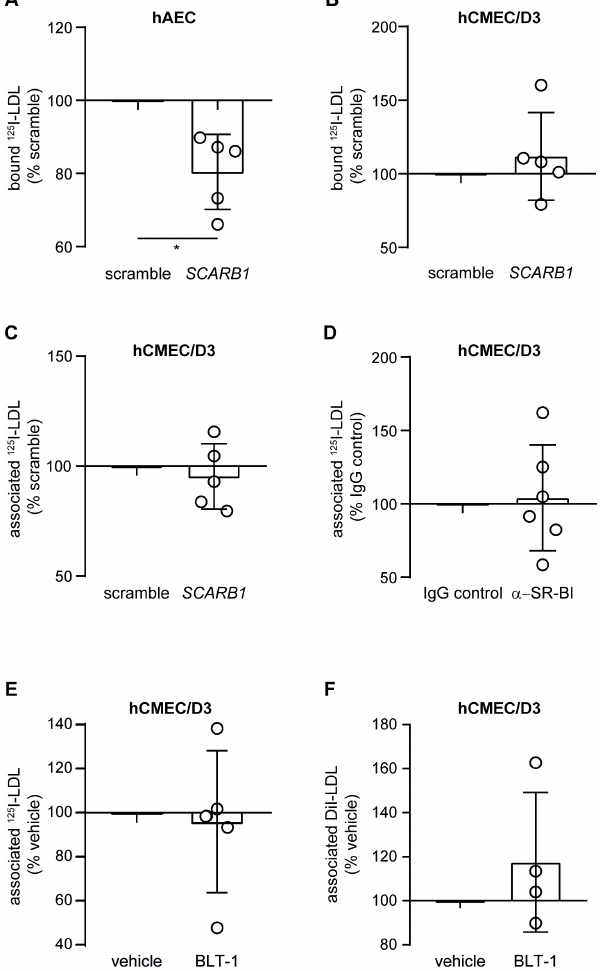
Figure 4. Inhibition of SR-BI reduces LDL binding to hAEC but not to hCMEC/D3. Seventy-two hours after silencing SCARB1 using siRNA, I 125 -LDL binding (4 ◦ C) to hAEC ( A ) or hCMEC ( B ) was measured as above. I 125 -LDL association (37 ◦ C) to hCMEC/D3 was measured as above 72 h after RNA interference against SCARB1 ( C ) or after treatment with an antibody blocking SR-BI ( D ). The role of SR-BI selective uptake was assessed by treating hCMEC/D3 with 1 µ M BLT1. After 30 min, I 125 -LDL ( E ) or DiI-LDL ( F ) association were measured as above. Points in graphs represent individual experiments (biological replicates, n = 4–6), bars represent the mean and error bars ± SD, * p = 0.05. The transmembrane serin/threonine receptor kinase ALK1 was previously reported to promote LDL holoparticle transport through human umbilical endothelial cells (hUVEC) and hAEC [3]. In our hAEC, RNA interference against ACVRL1 significantly reduced the expression of ACVRL1 transcript (Supplementary Figure S4A) but also the level of LDLR and SCARB1 (Supplementary Figure S4B). On the protein level, the abundance of ALK1 and LDLR but not SR-BI was significantly reduced after RNA interference against ACVRL1